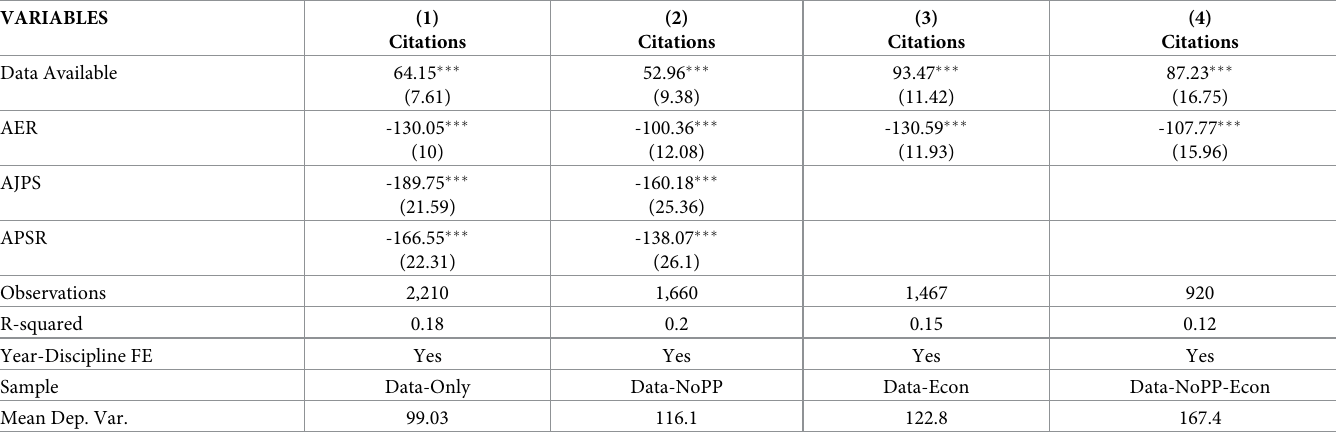
Table 2. OLS estimates of citations and data sharing.